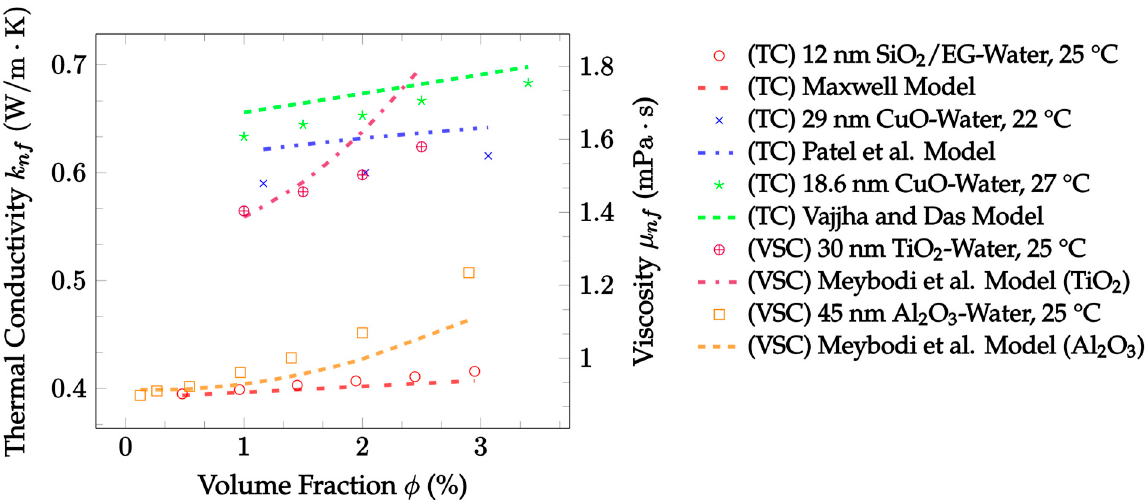
Figure 18. Thermal conductivity and viscosity of various nanofluids as a function of volume fraction with corresponding theoretical predictions: (TC) 12 nm SiO 2 /EG–water, 25 °C [109], (TC) Maxwell Model [14], (TC) 29 nm CuO–water, 22 °C [66], (TC) Patel et al. Model [23], (TC) 18.6 nm CuO–water, 27 °C [12], (TC) Vajjha and Das Model [22], (VSC) 30 nm TiO 2 –water, 25 °C, [111], (VSC) Meybodi et al. Model (TiO 2 ) [49], (VSC) 45 nm Al 2 O 3 –water, 25 °C [112], (VSC) Meybodi et al. Model (Al 2 O 3 )